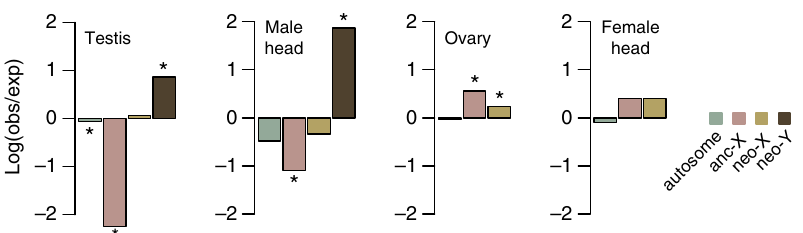
Fig. 4 Tissue expression enrichment across the genome. Relative enrichment of genes detected only in the focal tissue (observed vs. expected gene counts detected at ≥ 1 fragments per kilobase per million reads mapped or FPKM, see Supplementary Table 5). Signi fi cant enrichment (positive values) or depletion (negative values) of gene counts is based on a hypergeometric test (* p <